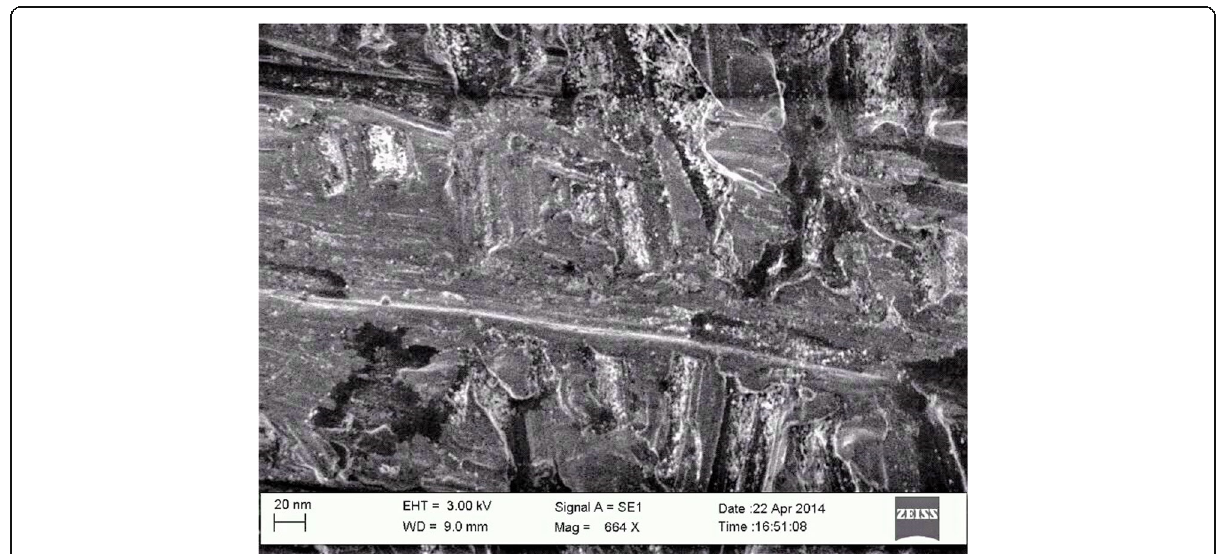
Fig. 9 Scanning electron microscopy (SEM) of lyophilized nanoparticles